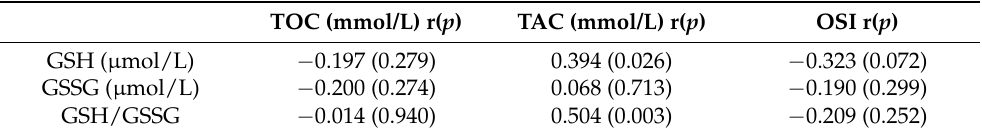
Table 4. Correlations between serum concentrations of total oxidant and antioxidant capacity and glutathione concentrations in healthy children.